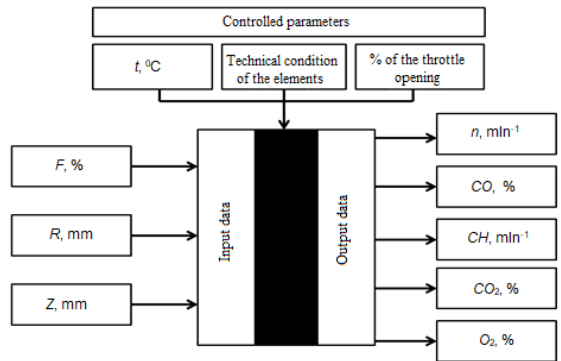
Figure 9. A model of input and output factors taking into account the controlled parameters